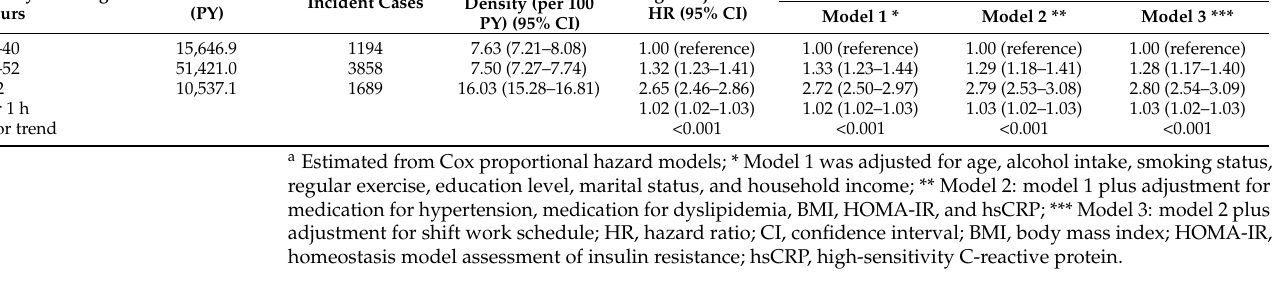
Table 2. Incidence and risk of glucose intolerance according to weekly working hours.